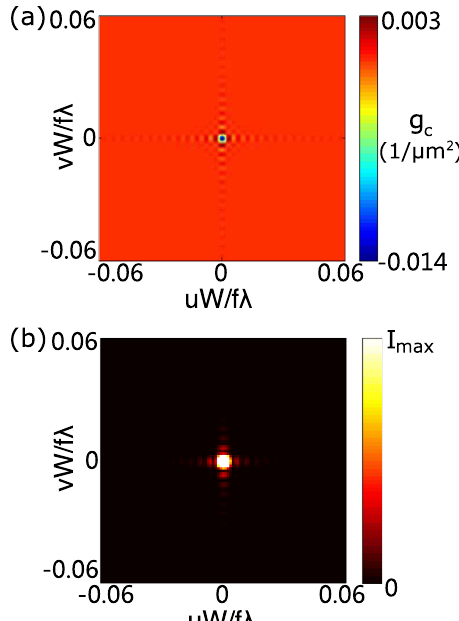
Fig. 2 Optoelectronic correlation computing for antiferromagnetic